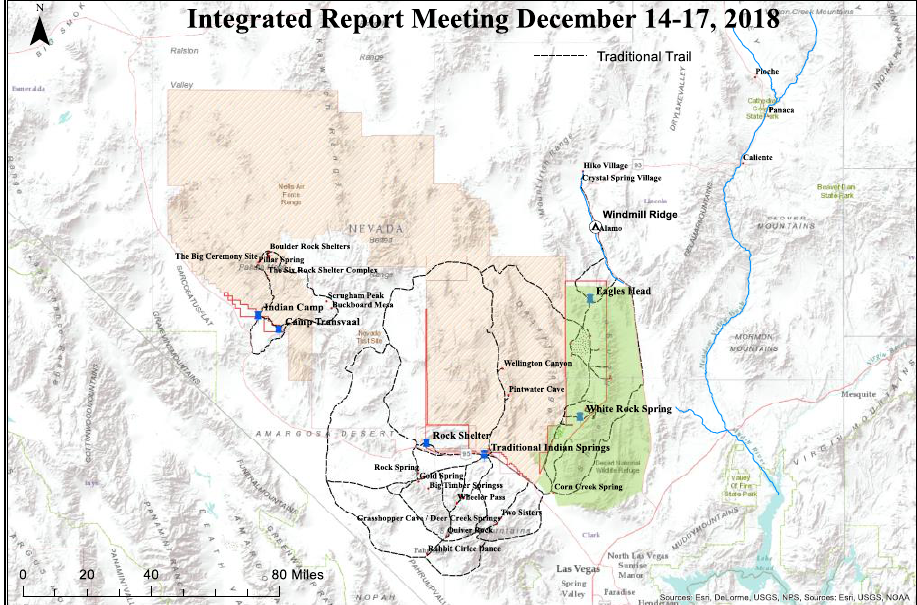
Figure 3. Federal agency boundaries and documented traditional trails